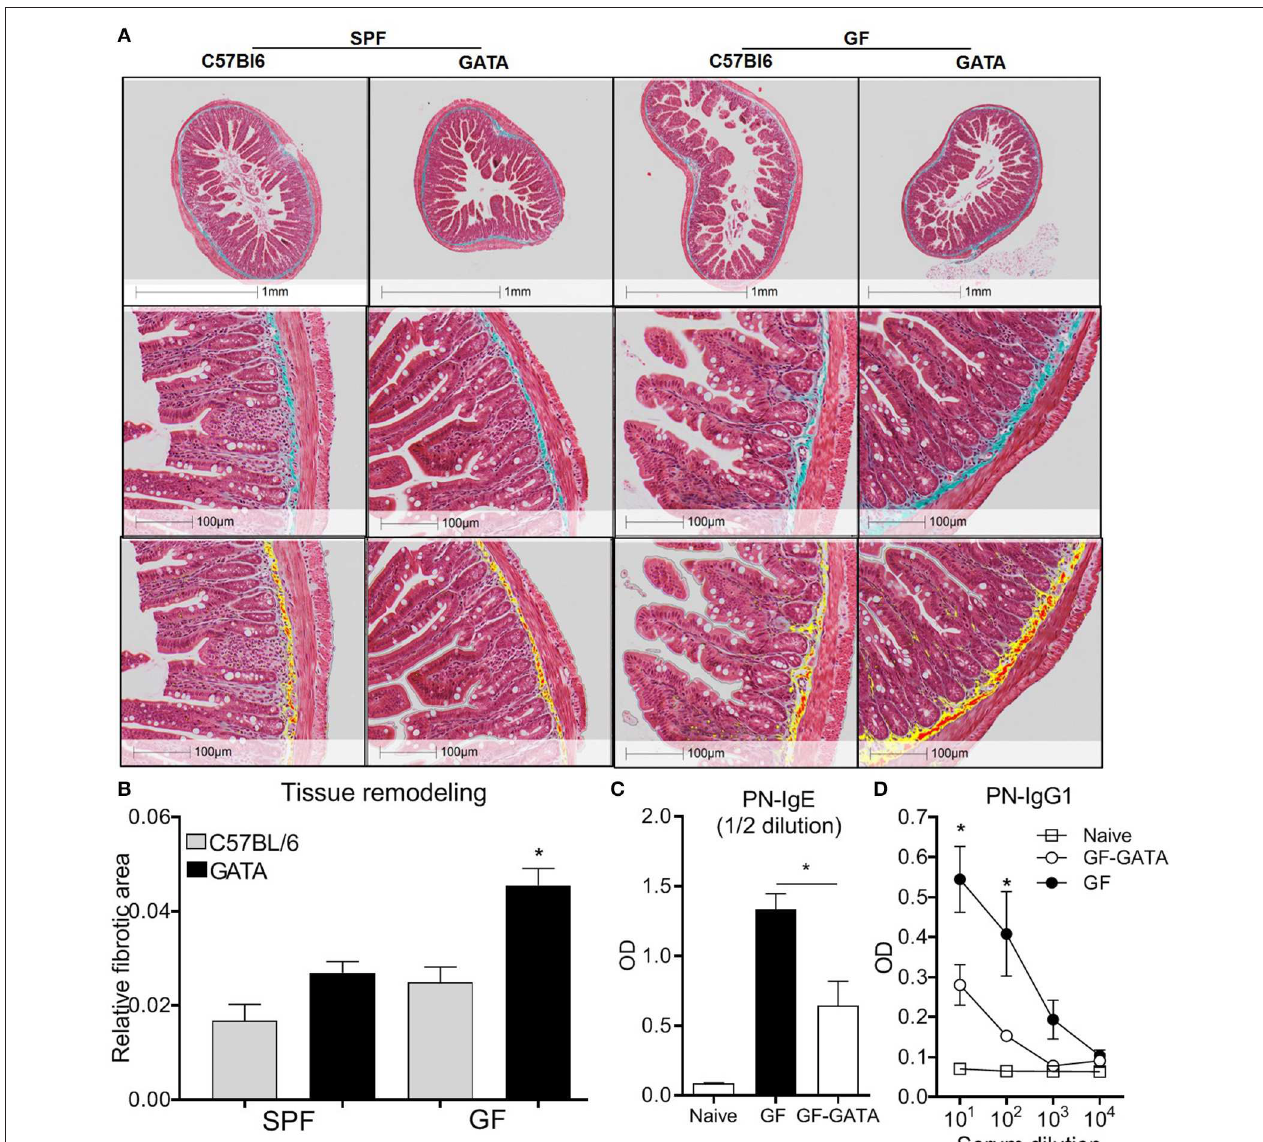
FIGURE 6 | Representative histological examples of intestinal fibrosis ( A , upper panels) and associated Halo quantification of fibrotic surface on digitalized (20X) sections where yellow and red represents Masson’s Trichrome positive stain ( A , lower panels) and associated quantification (B) of overall fibrotic area performed on GF mice, eosinophil deficient GF mice (GATA-GF) and controls. GF mice, eosinophil deficient GF mice (GATA-GF) and controls were intragastrically sensitized to peanut (PN) and serum levels of PN-specific IgE (C) and IgG1 (D) were determined by ELISA. Data from 4 to 5 mice (A,B) or pooled data from 2 experiments ( n = 6) (C,D) represented as mean ± SEM, * P <